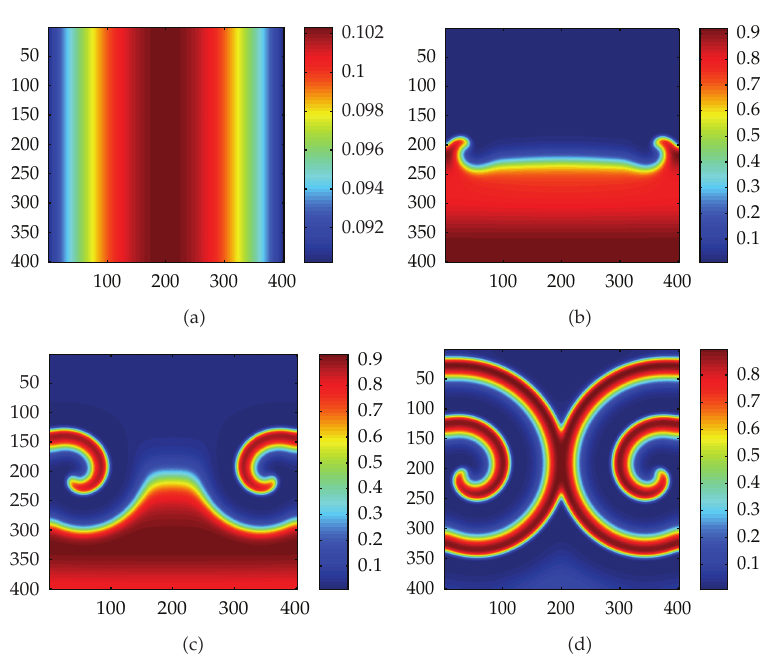
Figure 5: The process of spiral patterns of N for the parameters: α (cid:5) 2 . 5, β (cid:5) 1 . 3, γ (cid:5) 1 . 1, d 11 (cid:5) 0 . 7, d 12 (cid:5) 0 . 05, d 21 (cid:5) 0 . 01, d 22 (cid:5) 1. Time: (cid:7) a (cid:8) t (cid:5) 0, (cid:7) b (cid:8) t (cid:5) 200, (cid:7) c (cid:8) t (cid:5) 250, (cid:7) d (cid:8) t (cid:5) 500.